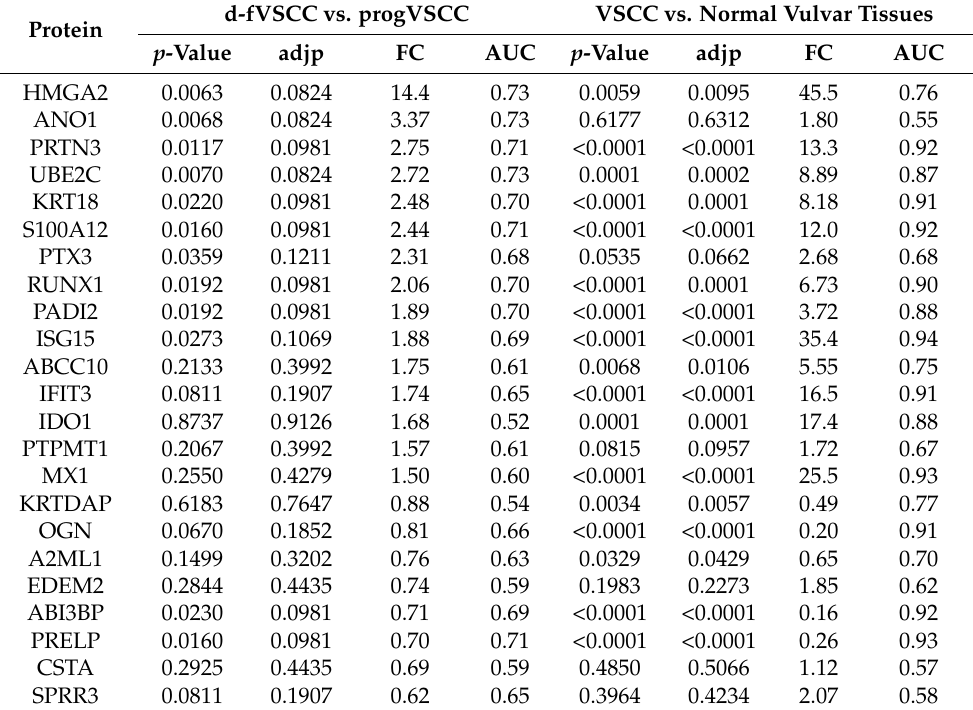
Table 1. The list of 23 differentially expressed proteins (DEPs) identified in the iTRAQ experiment and confirmed using PRM